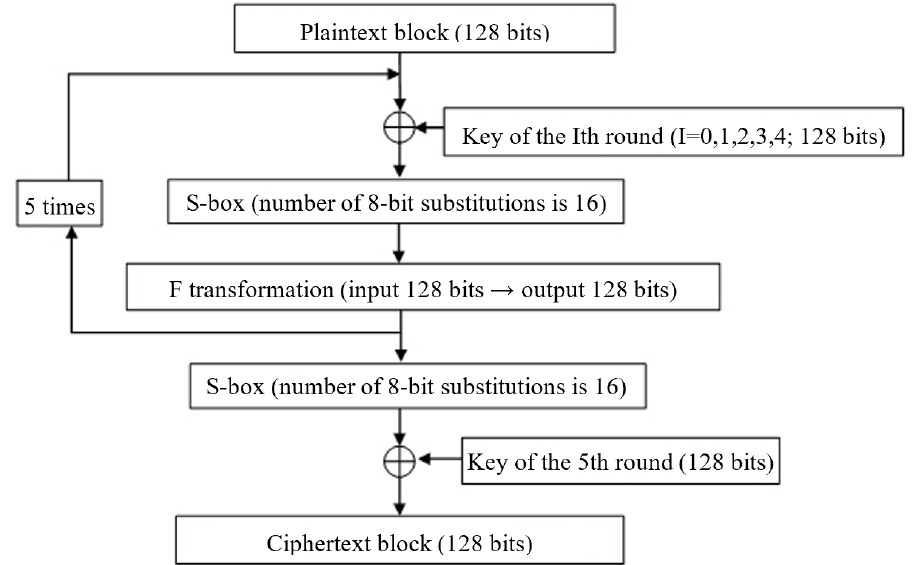
Figure 1. Scheme of the AL02 algorithm.